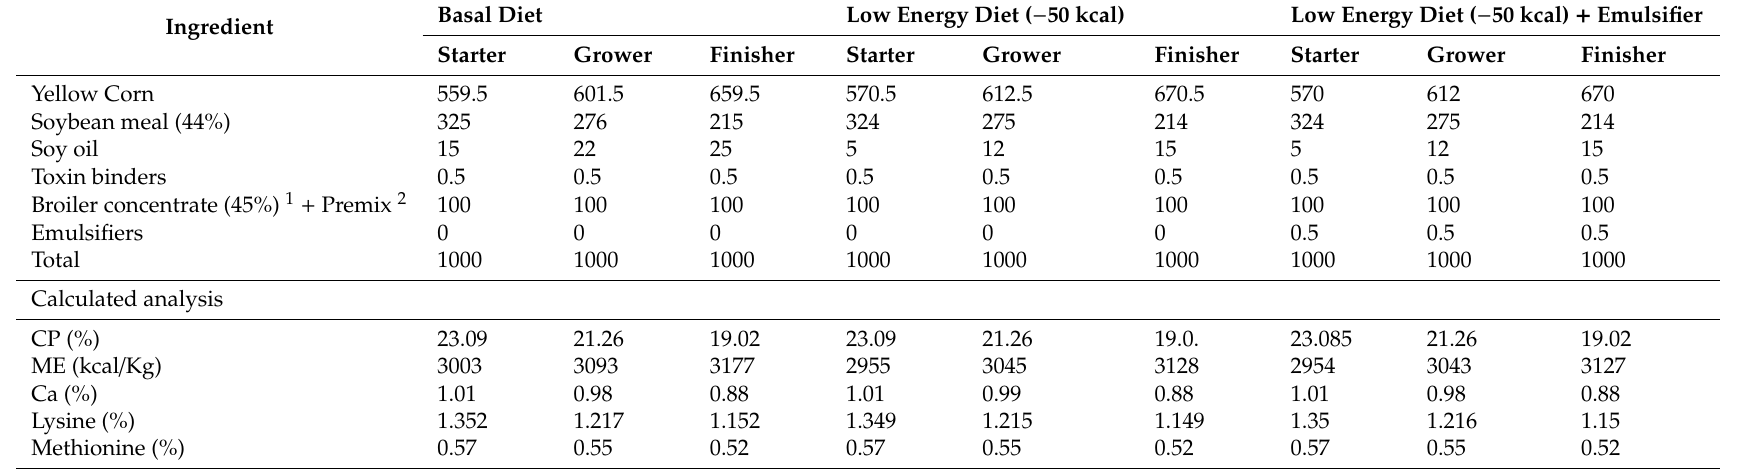
Table 1. Composition of the experimental